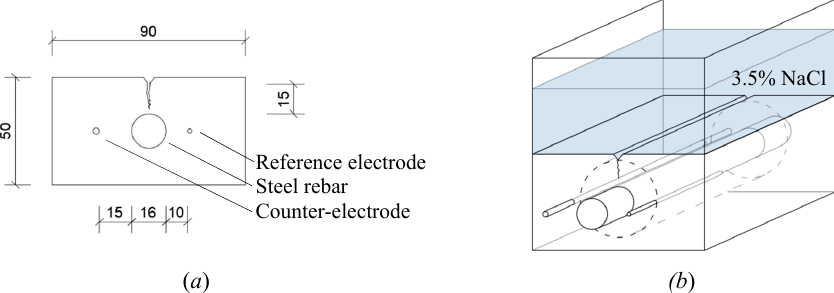
Figure 1. Geometry of the concrete specimens, dimensions in mm (a), and configuration of the ponding test and, in dotted line, concrete core taken for crack and corrosion observation